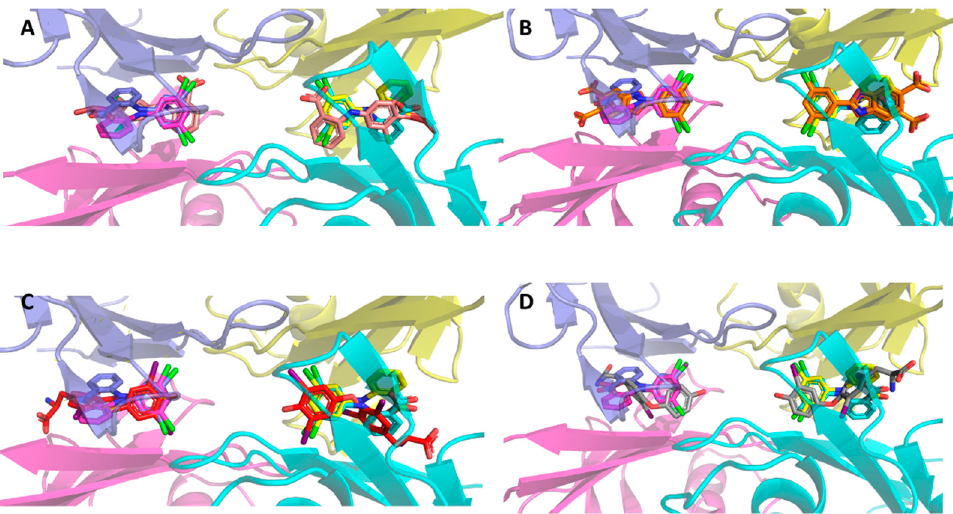
Figure 4. Comparisons of VCP-6 binding with other ligands. VCP-6 is colored as per Figure 3. ( A ) 2-[(3,5-dichloro-4-trioxidanylphenyl)amino]benzoic acid (wheat colored) [25] binds in the reverse mode. The addition of the trioxidane group makes the reverse binding mode favorable, exposing its functional group to the solvent at the channel entrance. ( B ) The drug tafamidis (orange) [13]. Note that the carboxyl ring of tafamidis occupies two alterative positions about the 2-fold axis of the channel. ( C ) Thyroxine (T 4 ) (red) [27], showing that VCP-6 binds deeper in the channel than T 4 . ( D ) 3,3 ′ -T 2 (grey) [7]. Note that the dichlorophenyl ring binds as deeply in the channel as the 3 ′ -iodo- phenyl ring of 3,3 ′ -T 2 .